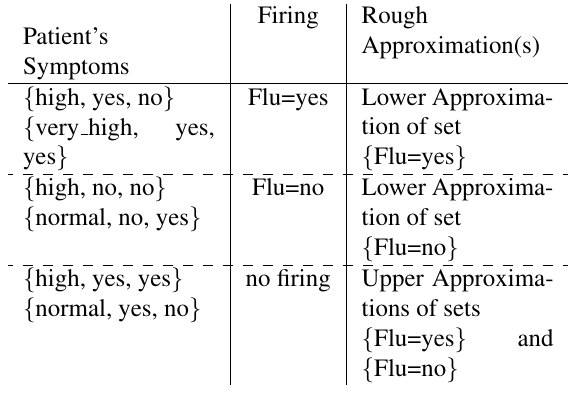
Table 2. Firing Rules and Rough Approximations.